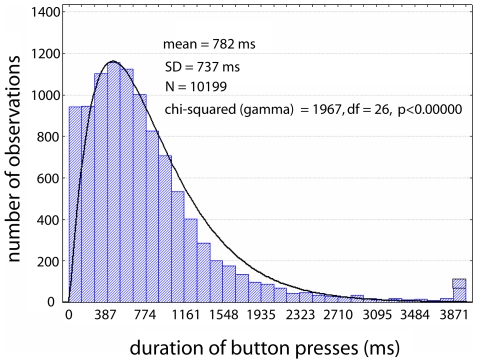
Distribution of durations for perceptual dominance periods.Data shown here were obtained from the 9 subjects included in the EEG analyses. Black curve indicates prediction of a gamma distribution with scale parameter = 400, shape parameter = 2.1, fitted to durations<4001 ms. Although the chi-squared value is highly significant the distribution fits well. It deviates most markedly for the shortest durations (of which there are more than predicted) and durations from about 1200 ms to 2000 ms (of which there are fewer than predicted).